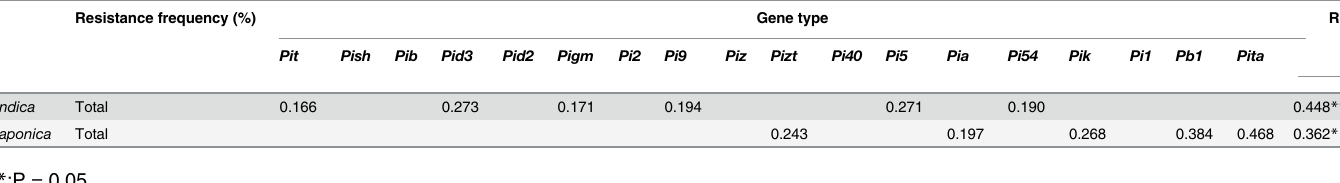
Table 2. The effect of rice blast resistance genes against M . oryzae .